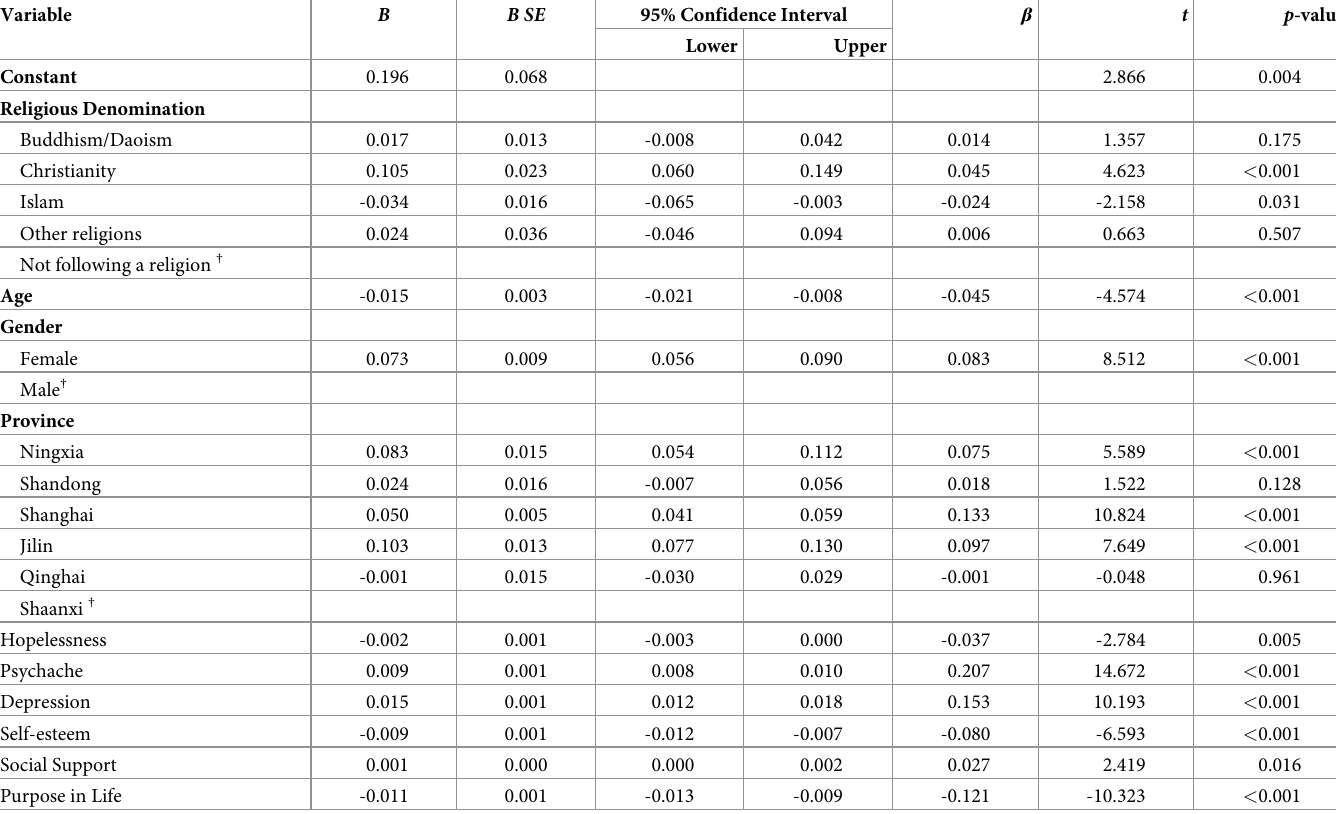
Table 3. Multiple linear regression analysis for factors predicting suicidality among college